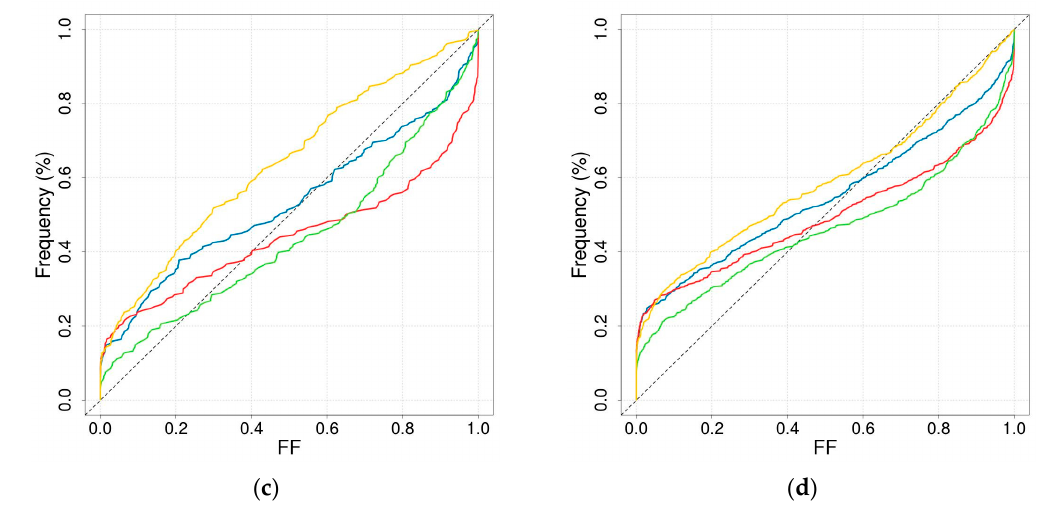
Figure 3. FF plot for the different regionalised FFAs. ( a ) All of France; ( b ) Plains zone; ( c ) Mediterranean zone; ( d ) Mountainous zone.